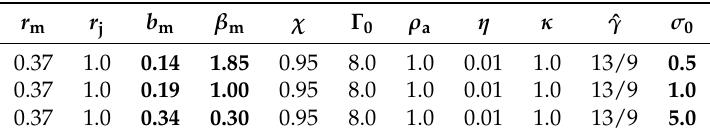
Table 1. Initial parameters for the special-relativistic magneto-hydrodynamical (SRMHD) in code units (varying values in bold